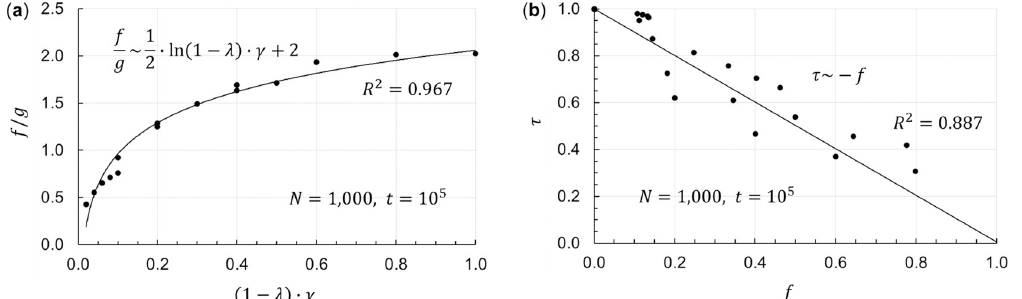
Fig 6. Relationship between λ , γ , f , g , and τ . In (a), the horizontal axis is (1 − λ ) � γ of the saving rate λ and the surplus contribution rate γ of the wealthy, and the vertical axis is f = of the total exchange f and the Gini index g . In (b), the horizontal g axis is f , and the vertical axis is the Kendall rank correlation coefficient τ . A substantial relationship can be seen for both (a) and (b) from the coefficient of determination R 2 of the regression equation. The number of agents is N = 1,000, and the times are t max = 10 5 , t 1 = 9.9 × 10 4 , and t 2 = 10 5 , the same as in Figs 4 and